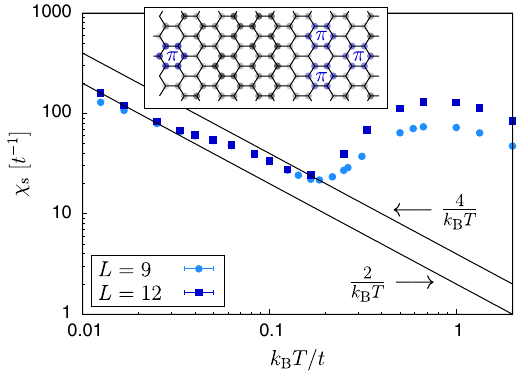
FIG. 8. Spin susceptibility as a function of temperature for four (cid:1) fluxes arranged as shown in the inset ( (cid:4)=t ¼ 0 : 2 , (cid:5) ¼ 0 , U=t ¼ 4 ) on L (cid:4) L lattices. The data reveal a Curie law 4 at k B T Curie law occur. at low temperatures. intermediate temperatures and 2 k B T k B T Statistical errors are smaller than the symbol size. Inset: S (cid:2) ð i Þ for L ¼ 15 , using the same color coding as in Fig.